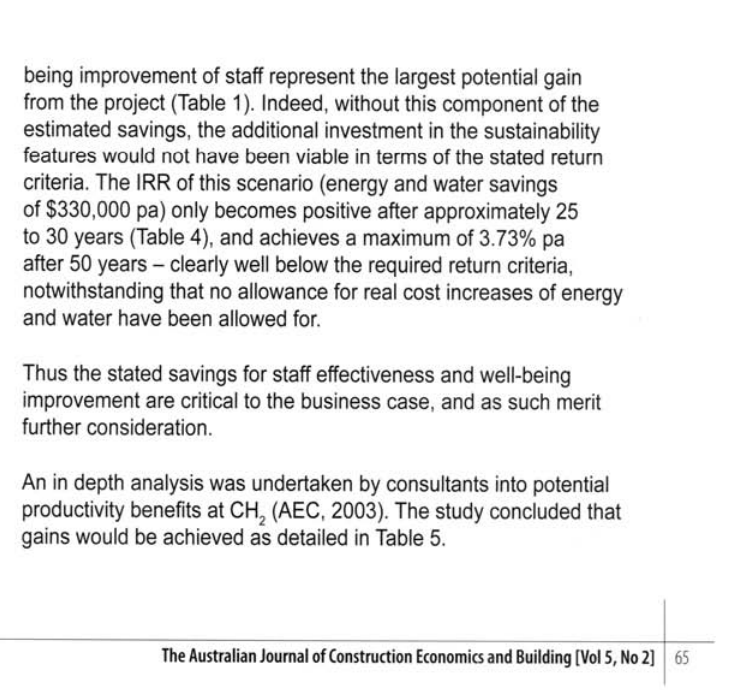
Table 4: Internal Rate of Return for Estimated